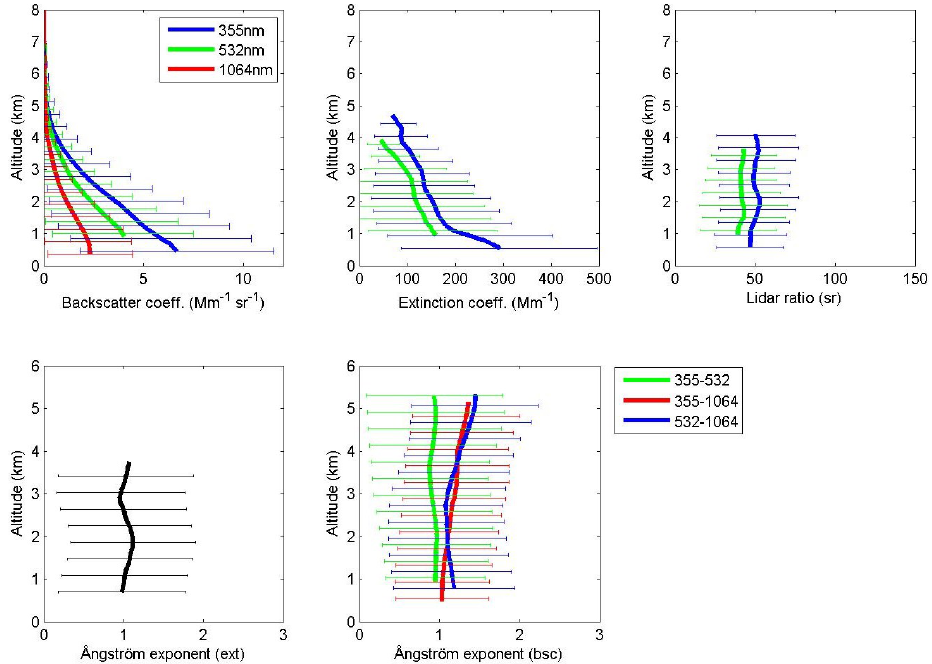
Fig. 8. Averages over the one-year measurement period for backscatter, extinction, lidar ratio and ˚Angstr¨om exponents with standard devia-